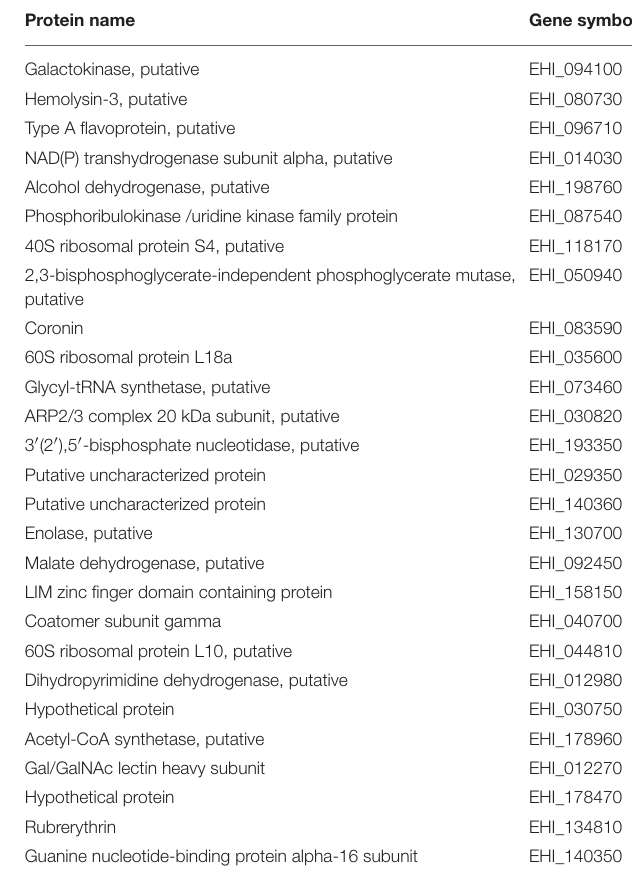
TABLE 1 | Cytoskeletal proteins identified by the PANTHER classification system. TABLE 2 | Common SNO proteins in NAT and in